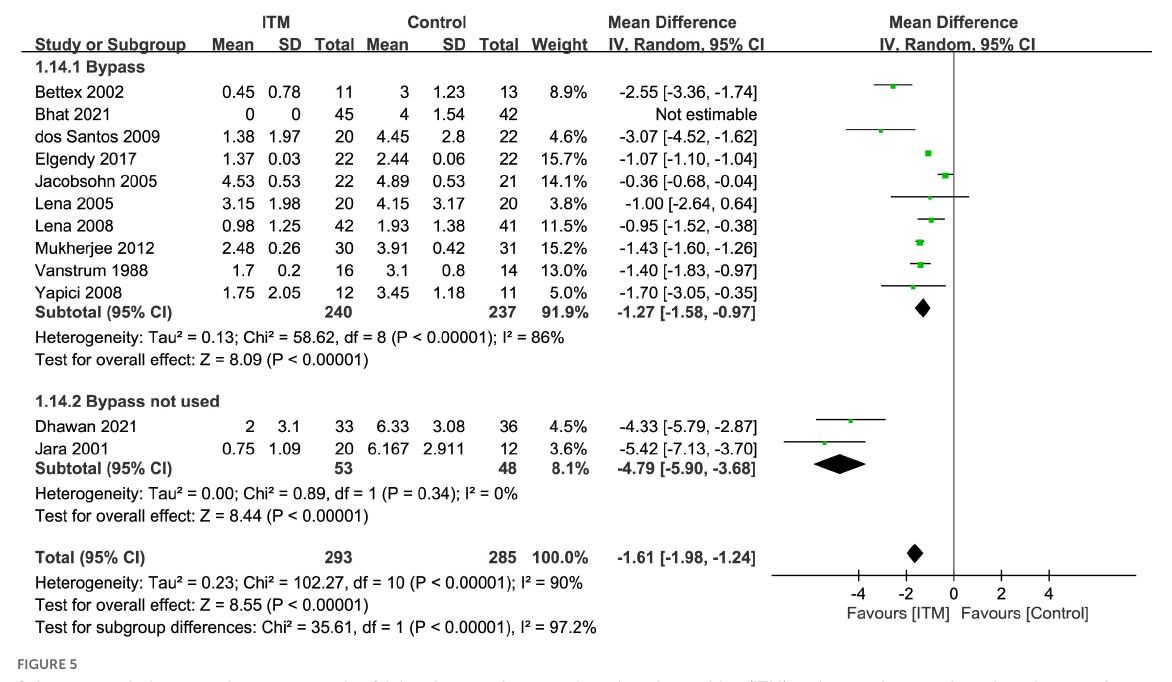
FIGURE5 Subgroup analysis comparing postoperative 24-h pain score between intrathecal morphine (ITM) and control groups based on the use of cardiopulmonary bypass. CI, confidence interval; IV, inverse variance; SD, standard deviation.